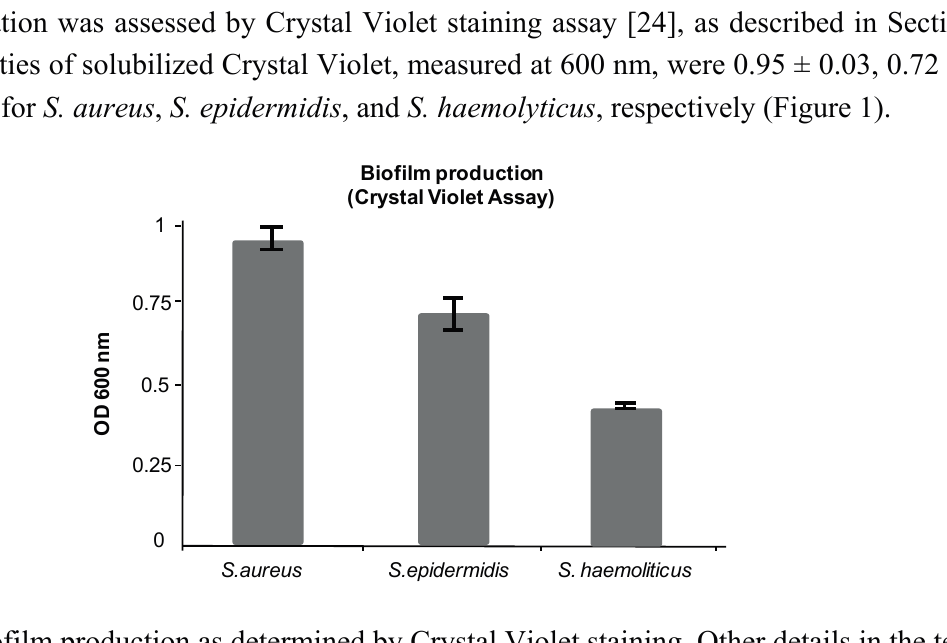
Figure 1. Biofilm production as determined by Crystal Violet staining. Other details in the